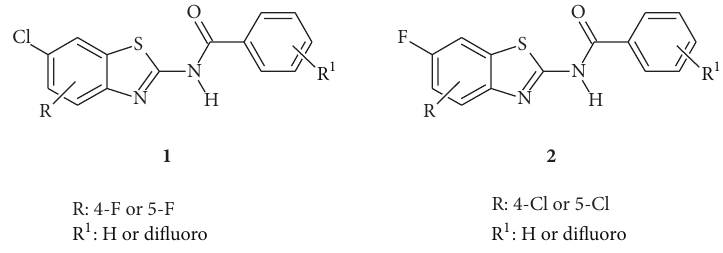
Figure 1: Structures of compounds 1 and 2 .